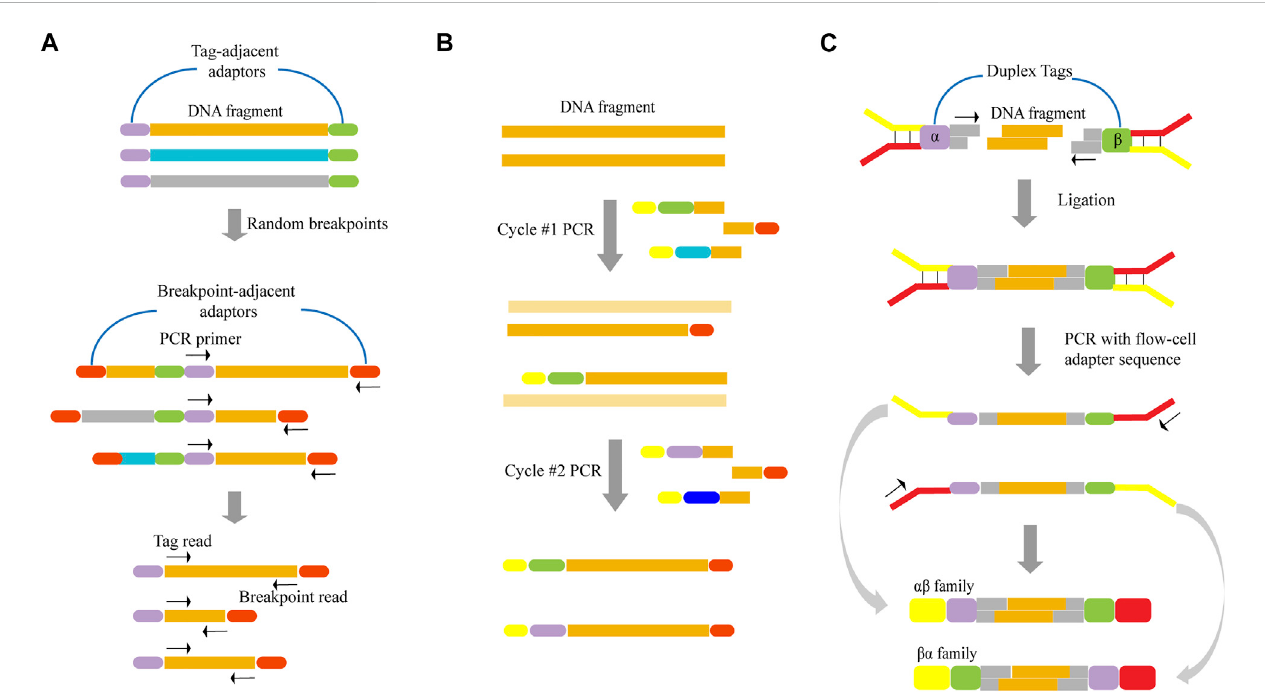
FIGURE 2 Schematics of various template tagging methods. (A) Using unique random shear points as template tags. Lone DNA fragments are ligated to tag- adjacent adaptors, diluted and PCR-ampli fi ed. PCR products are sheared through sonication and ligated to breakpoint-adjacent adaptors. Next, a second roundofPCRampli fi cationisconducted,whereoneendcorrespondstoatag-adjacentadaptorandtheothercorrespondstoabreakpoint-adjacentadaptor. (B) Introducing exogenous tags into the template by PCR. The tagged template requires two rounds of PCR in which one primer has a random DNA sequence that forms the unique tag (various colored bars). Both primers have sequences that permit universal ampli fi cation in the next step (yellow and red bars). (C) Introducing exogenous tags into the template by ligation. The DNA fragment is ligated to adapters that contain duplex tags (purple and green bars), which becomes labeled with two distinct tags. Following PCR ampli fi cation, two kinds of tagged families ( αβ family and βα family) are